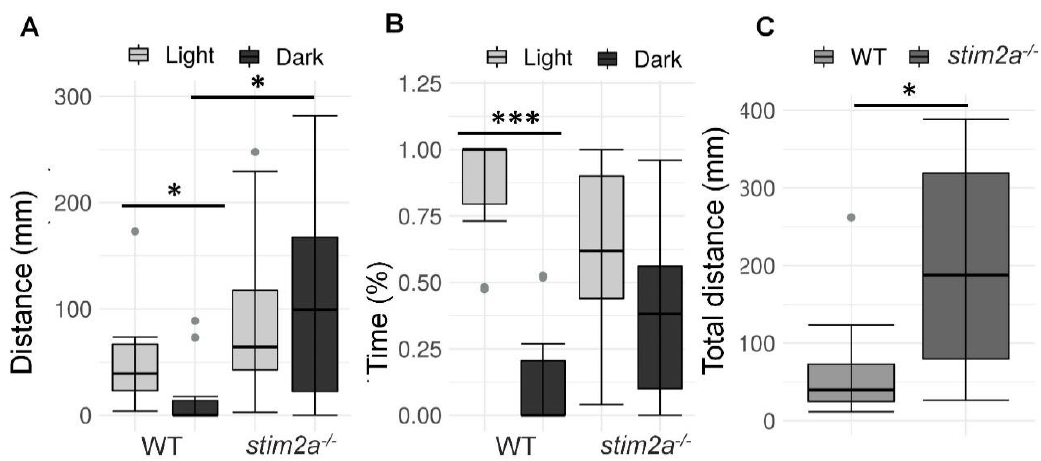
Figure 5. Hyperactivity and lower phototaxis in stim2a − / − fish in the light / dark preference test. This test was performed for 15 min, during which half of the Petri dish was covered with a photographic filter that blocked the light. ( A ) Box plots of the distance traveled (in millimeters) in the light and dark zones of the Petri dish in the WT and stim2a − / − larvae. ( B ) Box plots of the time spent moving (duration of movement) in the light and dark zones in WT and stim2a − / − larvae. ( C ) Box plots of the cumulative distance traveled (in millimeters) during the experiment by the WT and stim2a − / − larvae. * p < 0.05, *** p < 0.001 (paired Wilcoxon rank-sum test for comparisons between the light and dark zones; unpaired Wilcoxon rank-sum test for comparisons between WT and stim2a − / − larvae). n = 10 WT larvae. n = 11 stim2a − / − larvae. Number of experiments: 5.